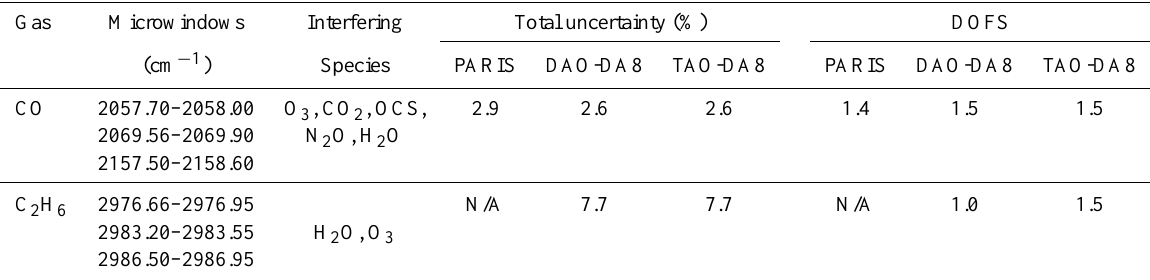
Table 1. Summary of retrieval microwindows and interfering species, with an estimate of the uncertainty of the retrieval and DOFS for each FTS. In each retrieval, multiple microwindows are fitted simultaneously as listed in the table below. For the calculation of the total uncertainty and contributions, see the description given in the